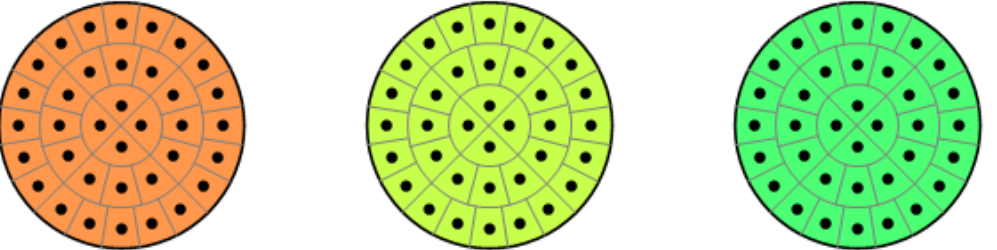
Figure 4. Interpretation of Equation (12).